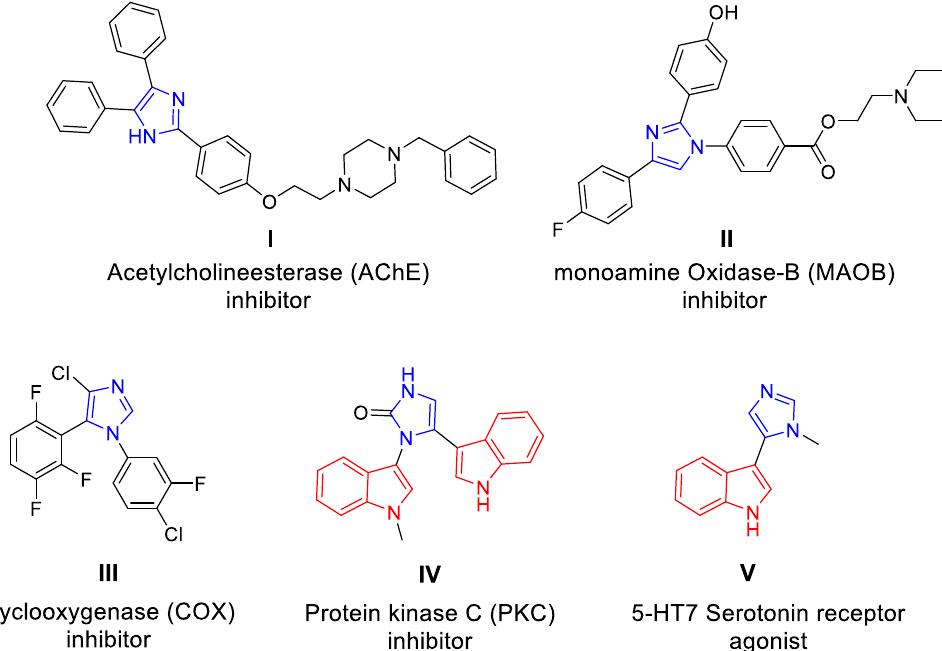
Figure 1. Active pharmaceutical ingredients (APIs) based on imidazole or indolyl-derived imidazole scaffolds (Blue color indicates the imidazole ring, red color shows the indole moiety).